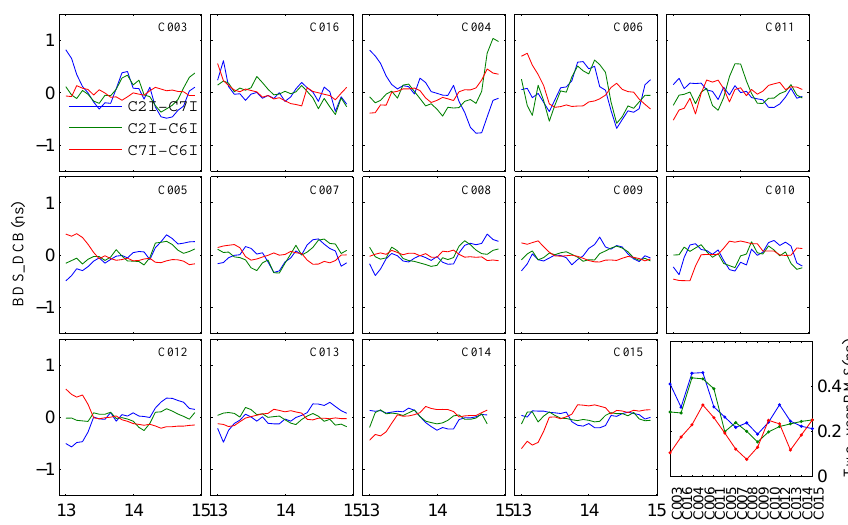
Figure 8. Monthly variations in BDS satellite DCBs for different frequency pairs. Here the 2-year mean values are subtracted. The bottom- right panel presents the 2-year RMS of 14 BDS satellites’ DCBs corresponding to C2I–C7I (blue), C2I–C6I(cyan), and C7I–C6I (red).